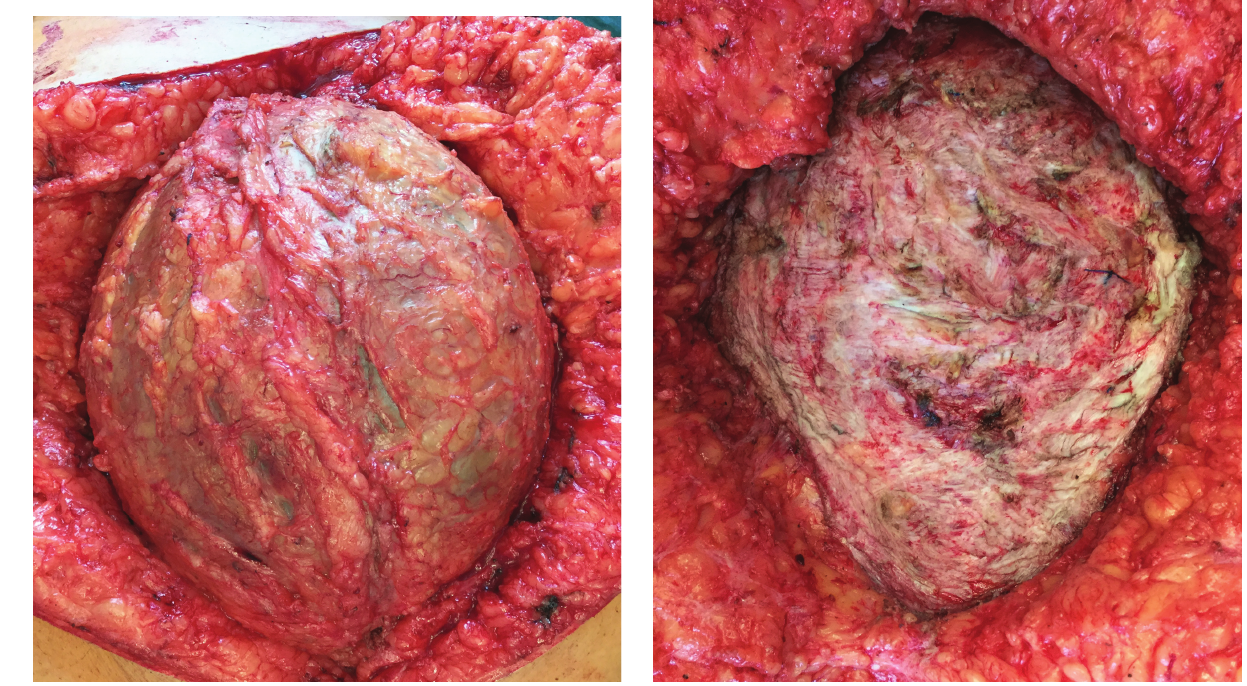
Figure 4: Anterior abdominal wall after encapsulated seroma excision